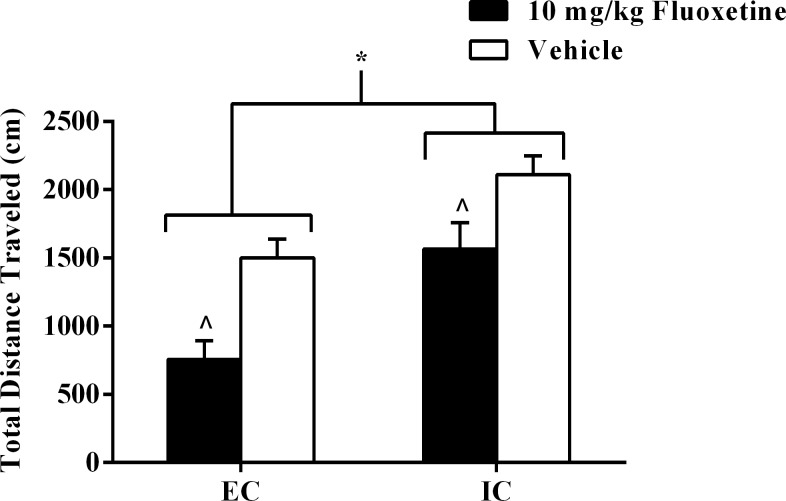
Experiment I Locomotor Activity following 10 mg/kg Fluoxetine.Experiment I total locomotor distance (cm) traveled (±SEM) in EC and IC rats after subchronic fluoxetine (10 mg/kg, i.p.) or vehicle administrations 23.5 hrs, 5 hrs, and 1 hr before the locomotor test. Asterisk (*) indicates that EC rats exhibited less locomotor activity than did IC rats. Caret signs (^) indicate that fluoxetine rats exhibited less locomotor activity than vehicle rats (p < .05).